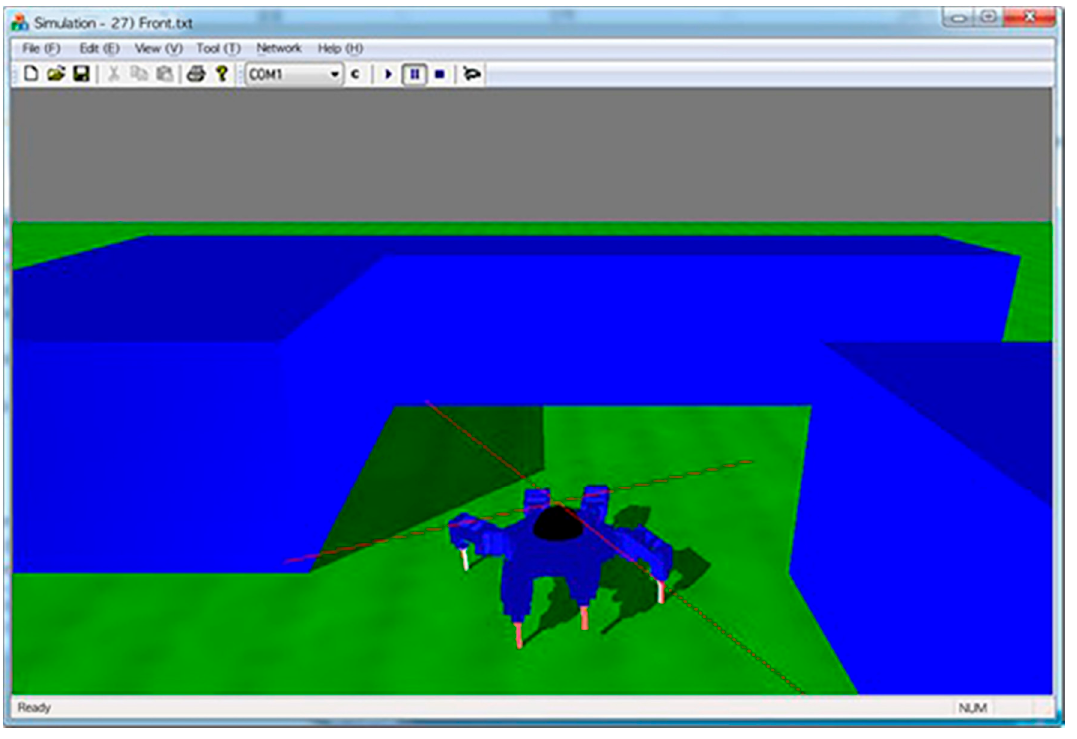
Figure 3. The multiple-joint robot